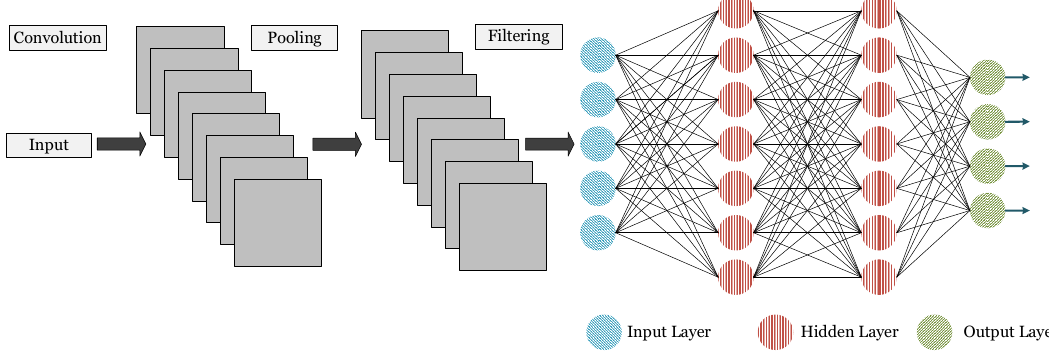
Figure 18. Illustration of convolution neural network